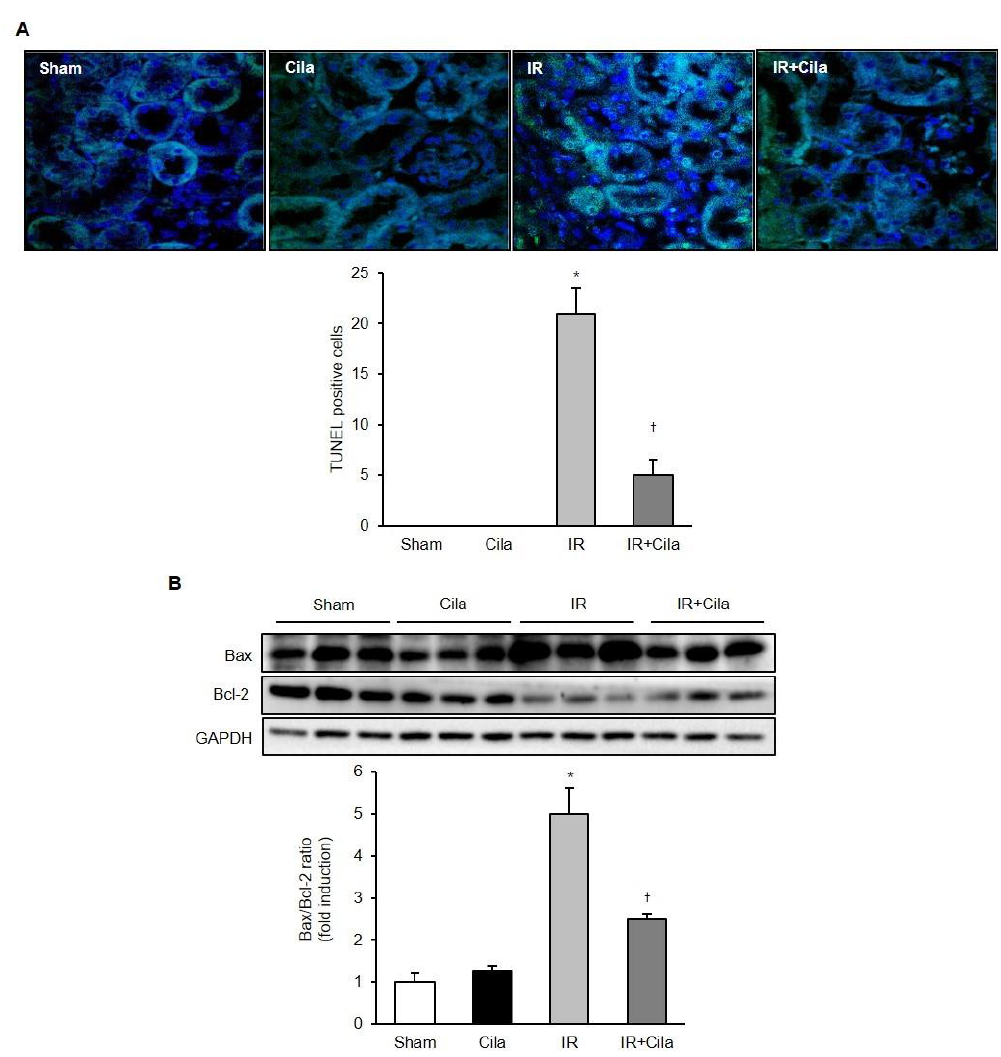
Figure 8. Cilastatin preconditioning attenuates apoptosis in mouse kidney with IR injury. ( A ) TUNEL assay revealed that cilastatin pretreatment significantly attenuated number of TUNEL-positive cells in mouse kidney with IR injury (original magnification, × 400). ( B ) Semiquantitative immunoblotting indicated that the level of pro-apoptotic marker, Bax, decreased in cilastatin-treated mouse kidney with IR injury, compared with mouse kidney with IR injury alone. Significant increase in levels of anti-apoptotic marker protein, Bcl-2, was noted after cilastatin pretreatment in mouse kidney with IR injury. The data are presented as means ± SEM. * p < 0.05 vs. sham and cila group; † p < 0.05 vs. IR group.